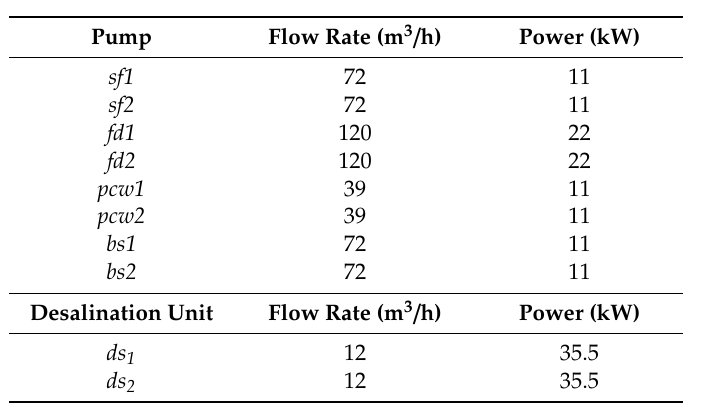
Table 2. Nominal flow rate and nominal power of the pumps and the desalination units in the desalination system.